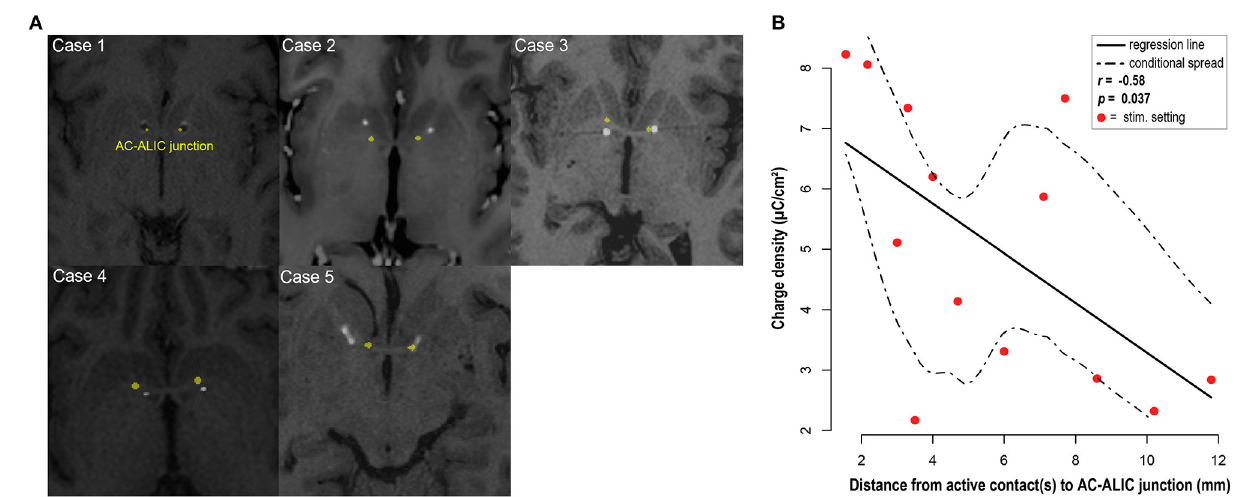
FIGURE 4 | DBS electrode placement. (A) For each patient, localization of the bilateral DBS leads is visualized in the axial plane at the level of the anterior commissure (AC) – anterior limb of the internal capsule (ALIC) junction; marked in yellow. Axial slices depict co-registered pre-operative MRI and post-operative CT for cases 2–5 and co-registered pre- and post-operative MRI for case 1. Hyperintense circular artifacts in cases 2–5 represent the DBS lead from the post-operative CT; the hypointense circular artifacts in case 1 represent the DBS lead. Note that the axial images depicting lead location at the junction between AC and ALIC, do not necessarily depict the location of the active contact. (B) Visualization and analysis of the association between the distance from the active contact(s) at final follow-up to the AC-ALIC junction and charge density. A significant negative correlation was observed for the relationship between distance between the active contact(s) and the AC-ALIC junction and charge density ( p = 0.037, r = −